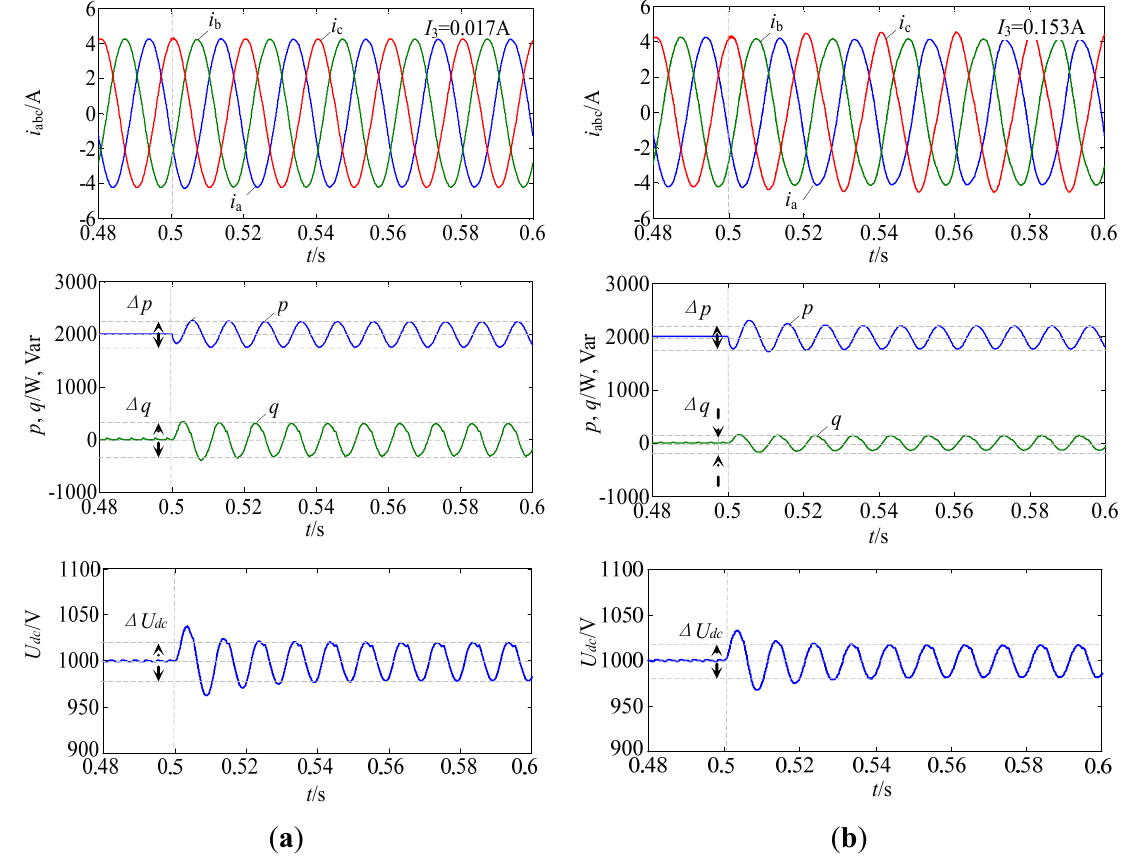
Figure 7. Operation characteristics of photovoltaic generation using control mode II: ( a ) I 3r = 0.004 pu and Δ P r = 0.1 pu and ( b ) I 3r = 0.04 pu and Δ P r = 0.1